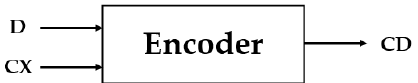
Figure 1. Arithmetic coder inputs and outputs.